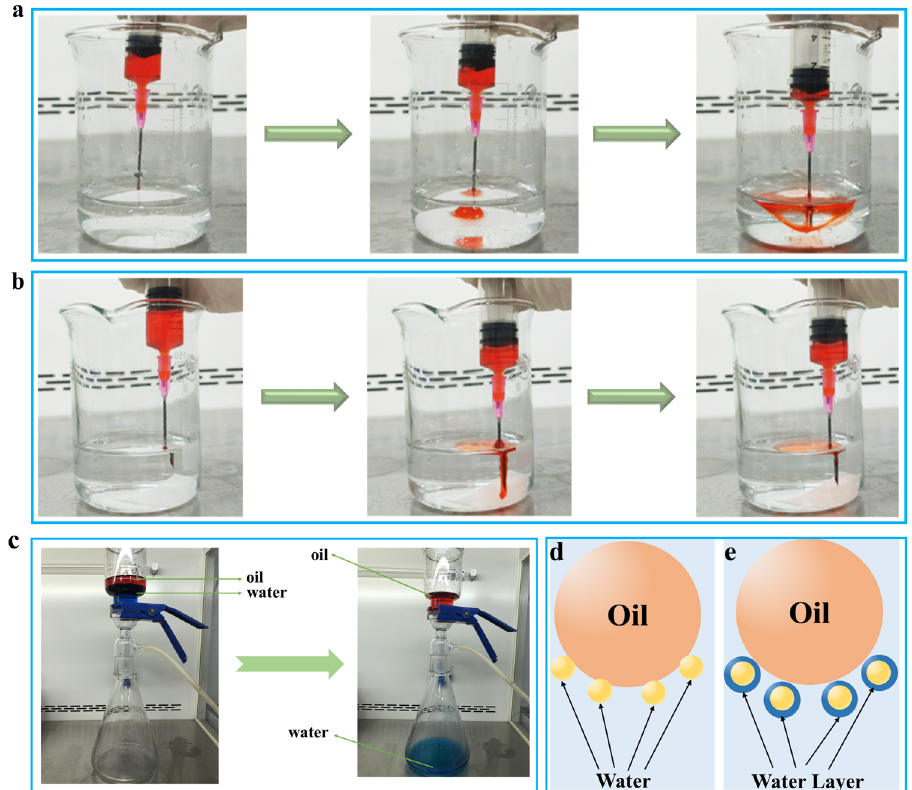
Fig. 4 Oil resistance of PVDF membrane and PVDF/PVA/LPB/MOF membrane. a The anti-oil stain experiment process of PVDF membrane. b PVDF/PVA/LPB/MOF membrane anti-greasy experiment process. c The device diagram of the oil/water/bacteria separation experiment. Schematic diagram of oil resistance of d PVDF and e PVDF/PVA/LPB/MOF